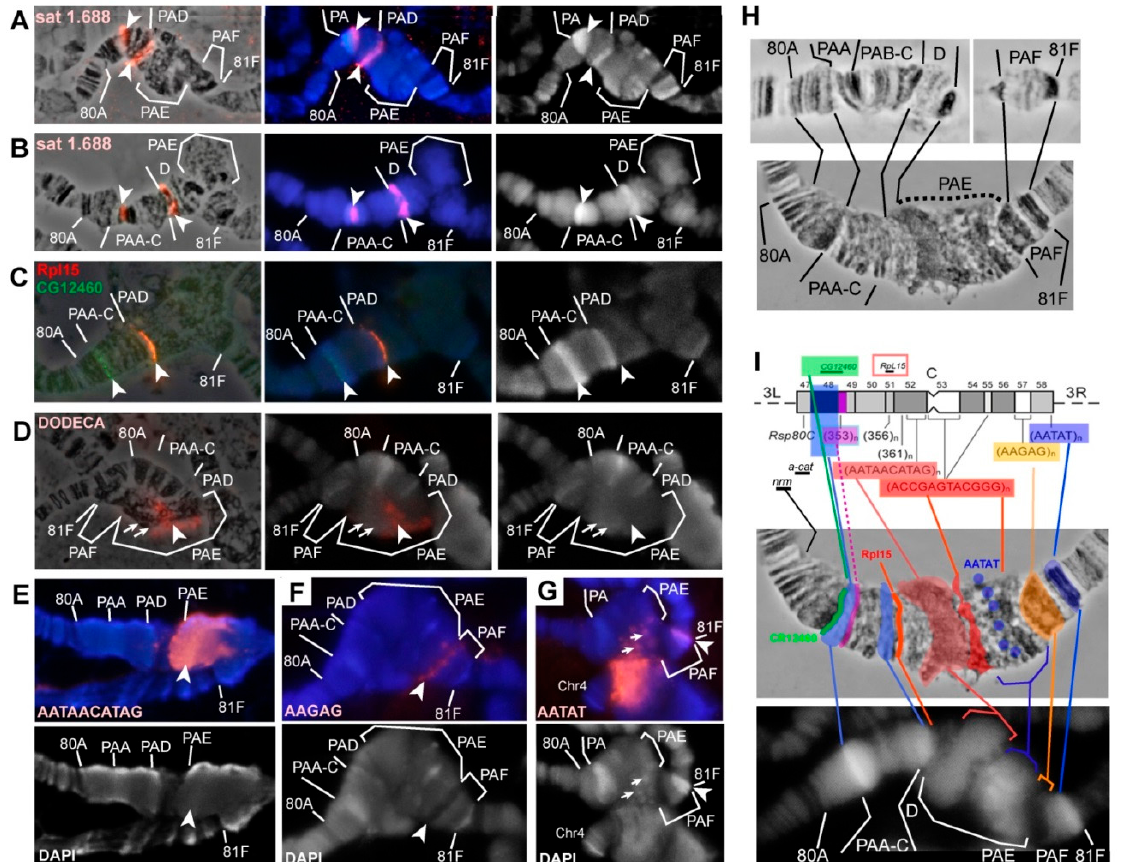
Figure 6. Determining the correspondence between the morphological structures of the pericentromeric heterochromatin of polytene chromosomes in the Rif1 mutants and the mitotic heterochromatin map of chromosome 3. ( A , B ) The probe specific to the het1.688 satellite hybridized with the chromosome of mutants Rif1 1 / Rif2 2 ( A ) and SuUR ES Su(var)3-9 06 ( B ) (the photo in B is adapted from [60]). ( C ) The probes specific to genes CG12460 (green) and Rpl15 (red) hybridized with the chromosome of Rif1 1 / Rif2 2 mutants. ( D – G ) FISH of satellite probes with Rif1 1 / Rif2 2 polytene chromosome 3; ( D ) Dodeca (ACCGAGTACGGG); ( E ) Prodsat (AATATCATAG); ( F ) AAGAG; ( G ) AATAT. The signals are superimposed with phase contrast images ( A – D , left column) and with DAPI staining ( A – D : middle column, E – G : upper row). The DAPI staining is presented in black and white. ( H ) Comparison of the morphological structures in Plato Atlantis in mutants SuUR ES Su(var)3-9 06 (top) and Rif1 1 / Rif2 2 (bottom). ( J ) Correspondence of morphological structures observed in the pericentromeric heterochromatin of chromosome 3 in the Rif1 mutants to the mitotic heterochromatin map. Di ff erent sequences are presented in di ff erent colors on the mitotic map and are plotted on the photograph of the polytene chromosome in the corresponding color at a site of their